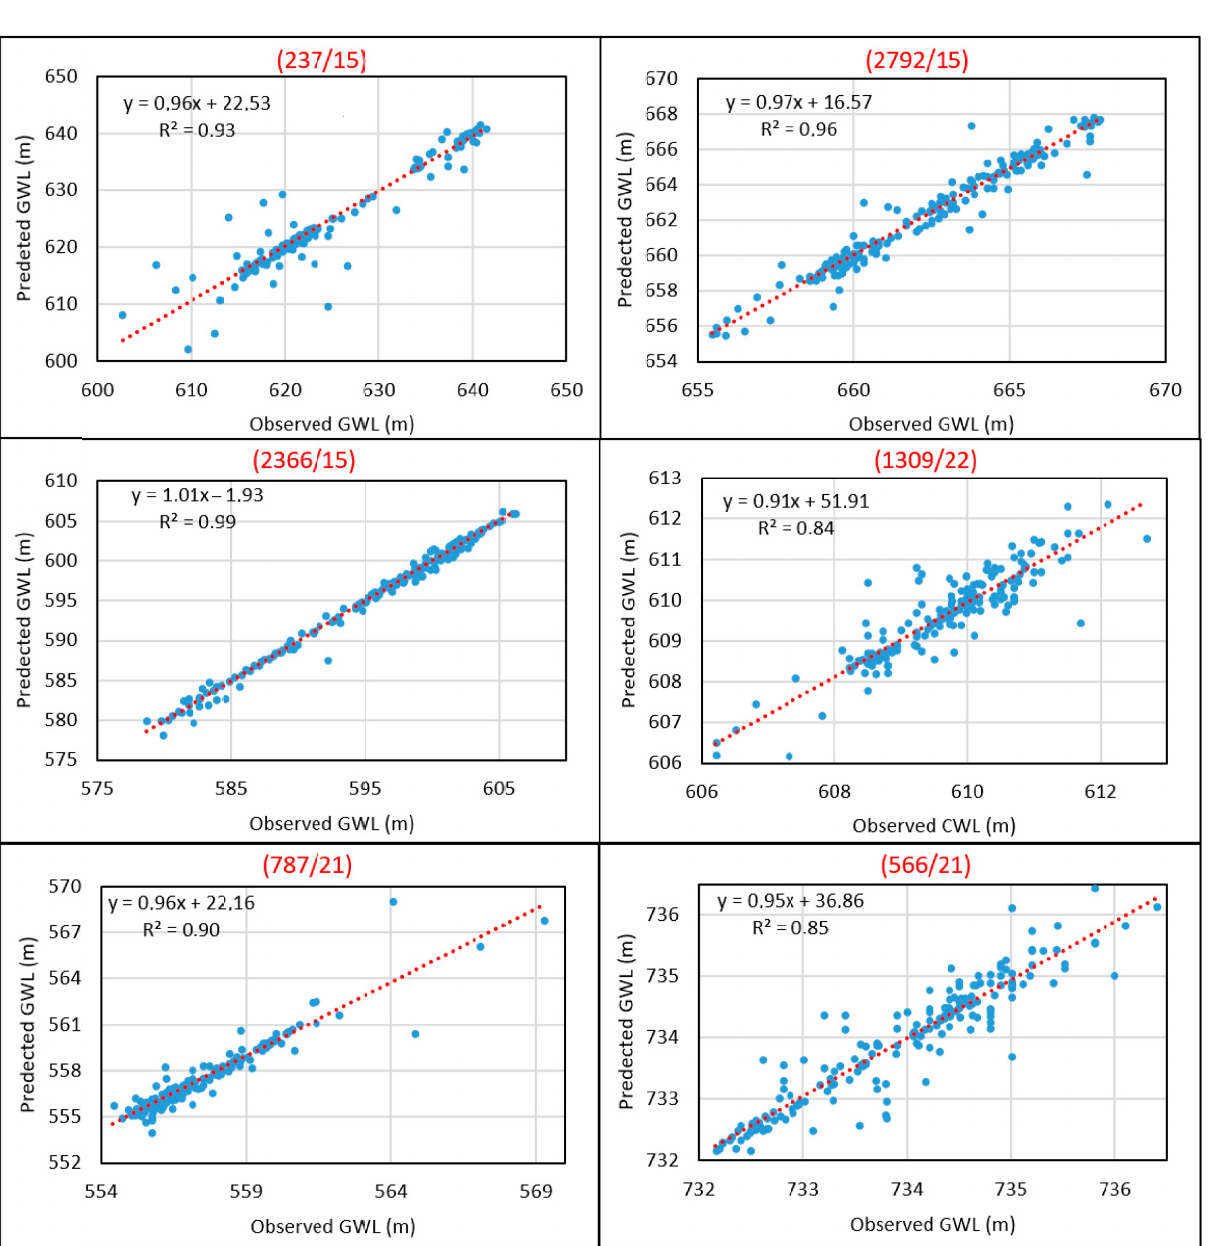
Figure 11. Scatterplot of predicted vs. observed values of groundwater level in six selected piezomet- ric